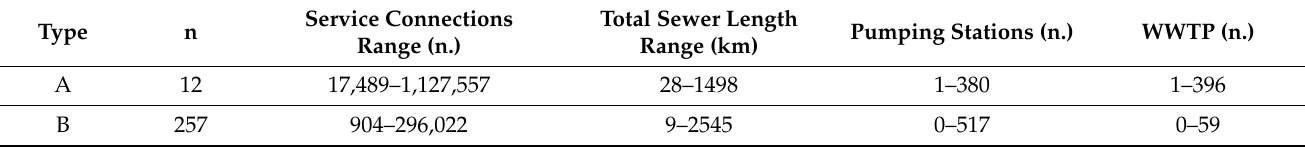
Table 1. Characteristics of systems used in